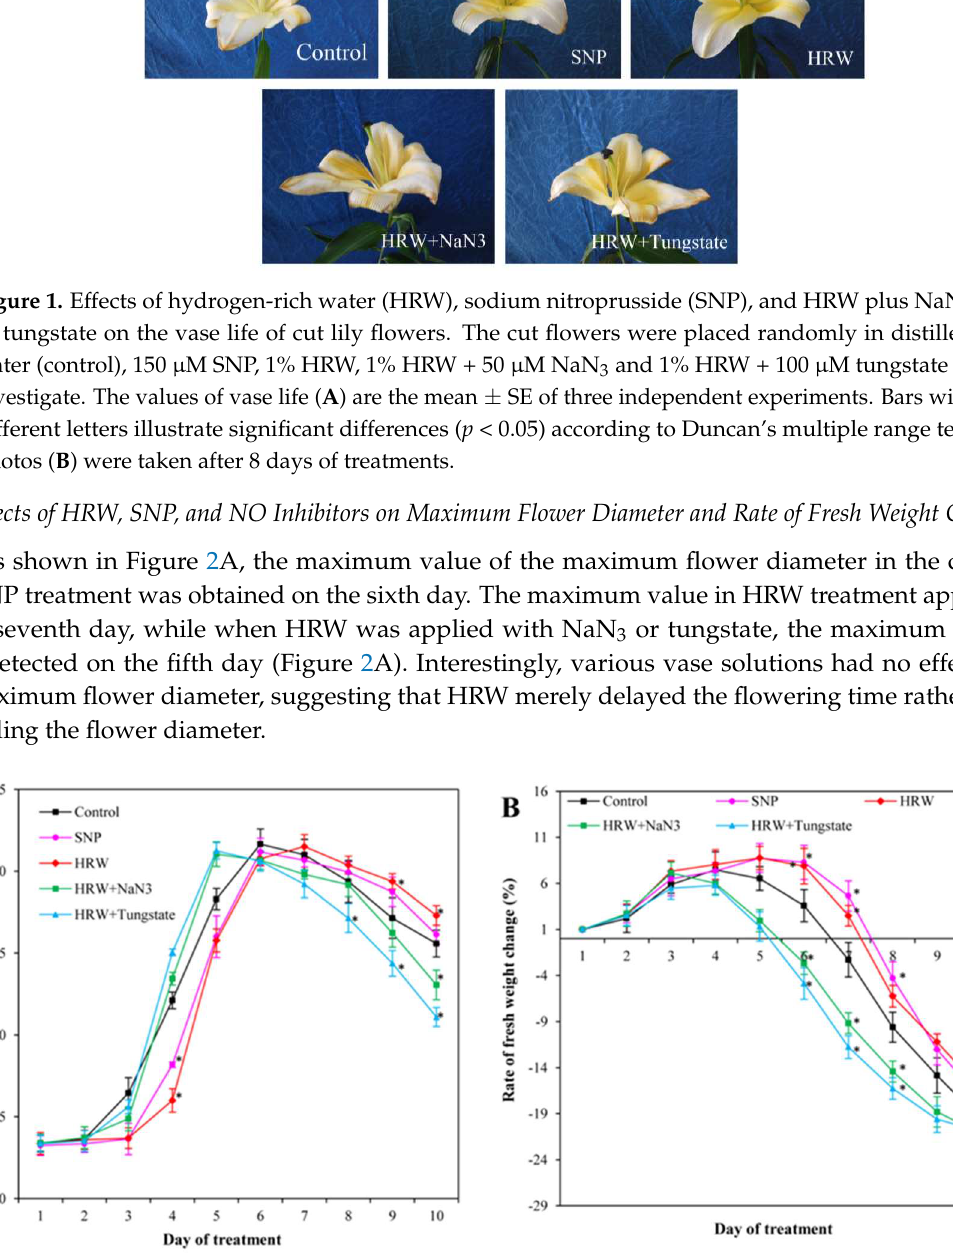
Figure 2. Effects of HRW, SNP, and HRW plus NaN 3 or tungstate on flower diameter and fresh weight of the cut lilies. Maximum flower diameter ( A ) and rate of fresh weight change ( B ) were expressed as mean ± SE of three independent experiments. Asterisks indicate significant difference ( p < 0.05 by Duncan’s multiple range test) compared to the control within the same